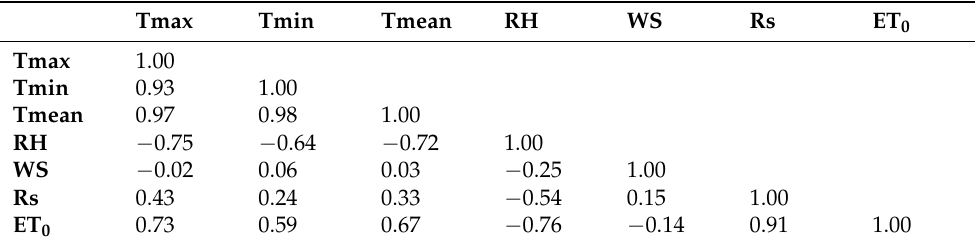
Figure 2. The structure of the ANN model. Table 2. Correlation matrix between ET 0 and meteorological